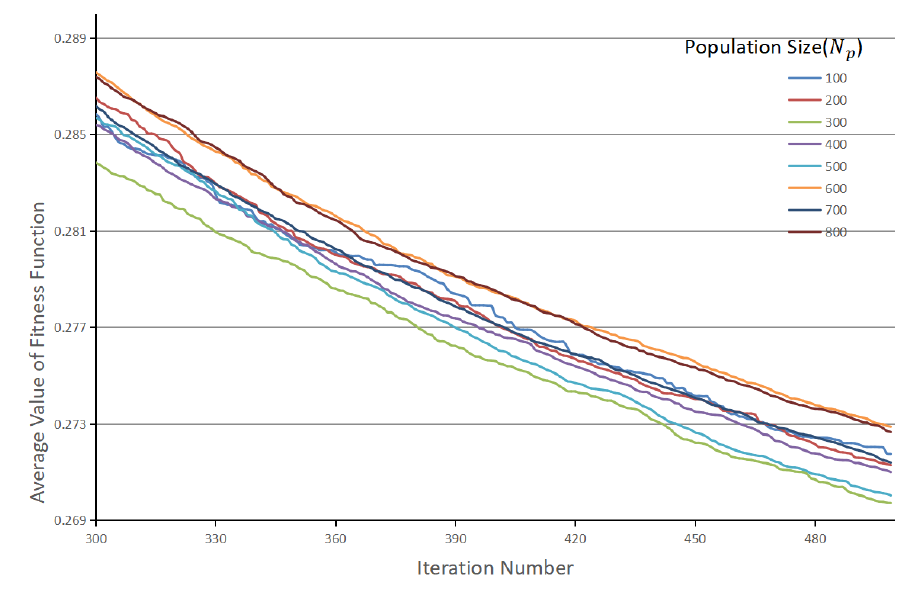
Figure 5. Average value of the fitness function under different population